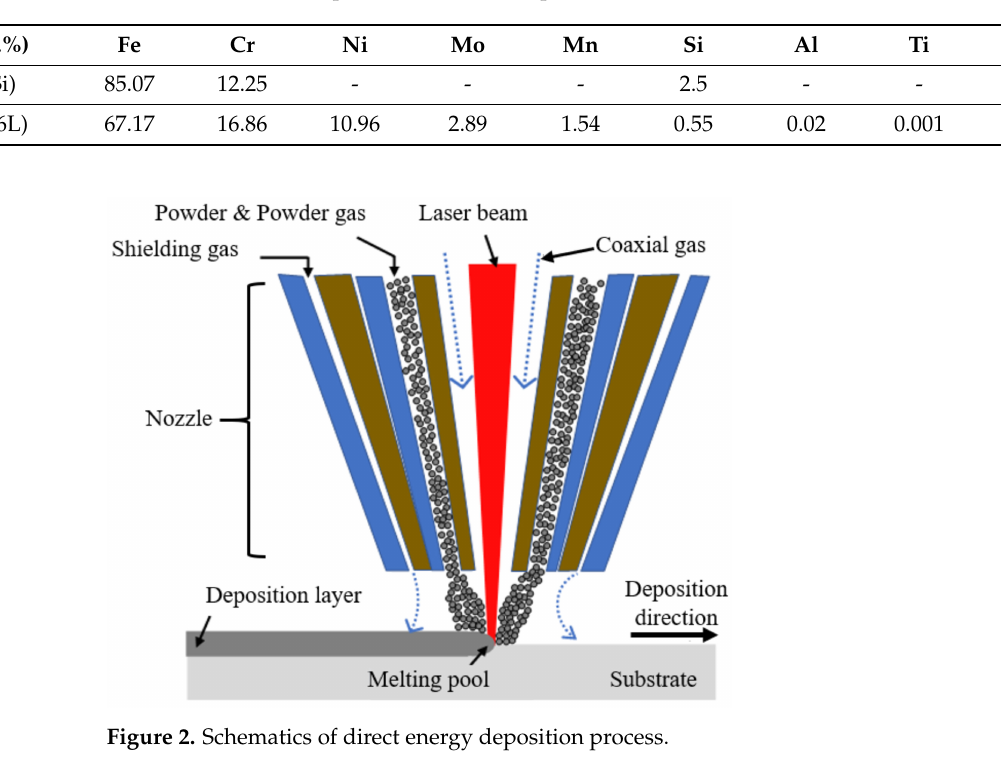
Table 1. Chemical compositions of Fe-Cr-Si powder and 316L stainless steel substrate.